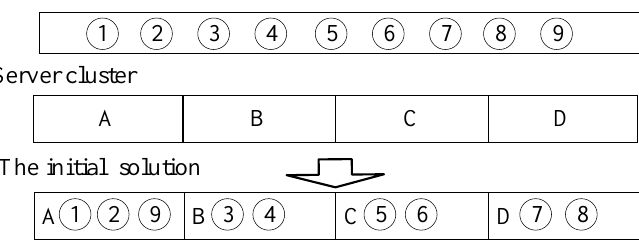
Figure 3. Solving the initial feasible solution.